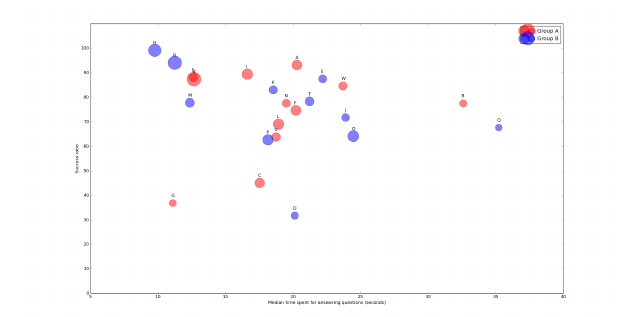
Figure 17. Variations in the error rate as a function of the median time spent answering the questions in the worksheets. The width of the point is proportional to the number of worksheets treated by the children and two different colors allow to visualize the two different groups of